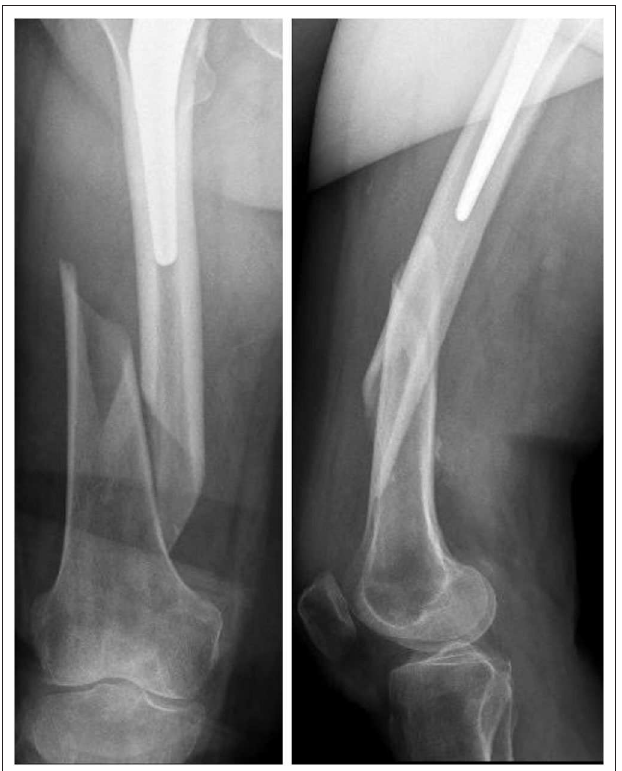
FIGURE 1 | Anteroposterior (Left) and lateral (Right) x-ray images of the periprosthetic fracture.